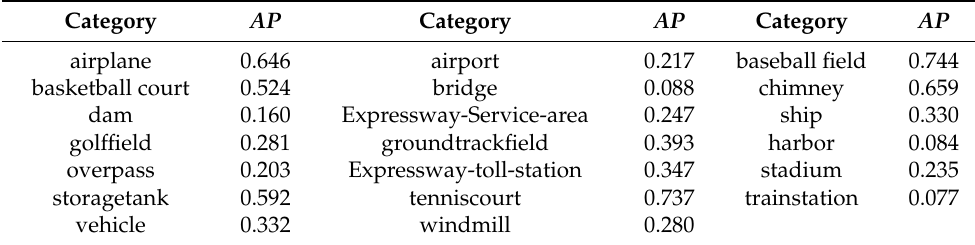
Table 6. The AP s of different categories by EFNet on the dataset DIOR.